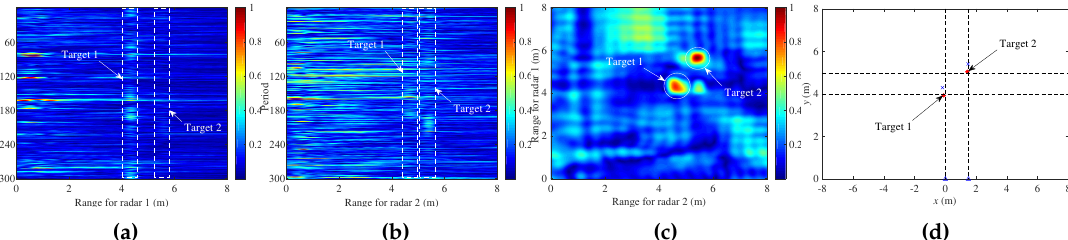
Figure 18. Results of Experiment 3.3: ( a ) range profile plane for Radar 1; ( b ) range profile plane for Radar 2; ( c ) cross-correlation image; and ( d ) localization